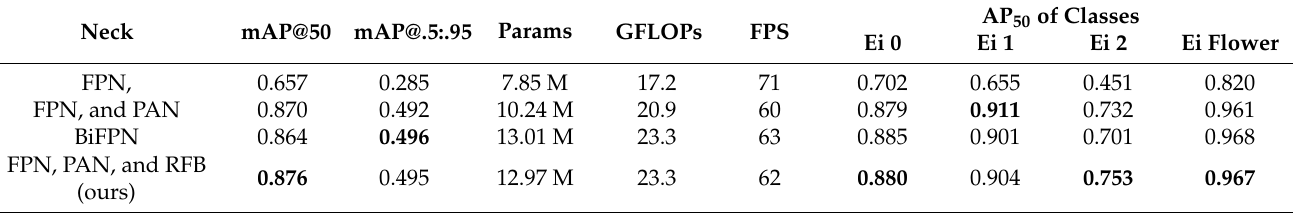
Table 5. Comparison of various feature fusion